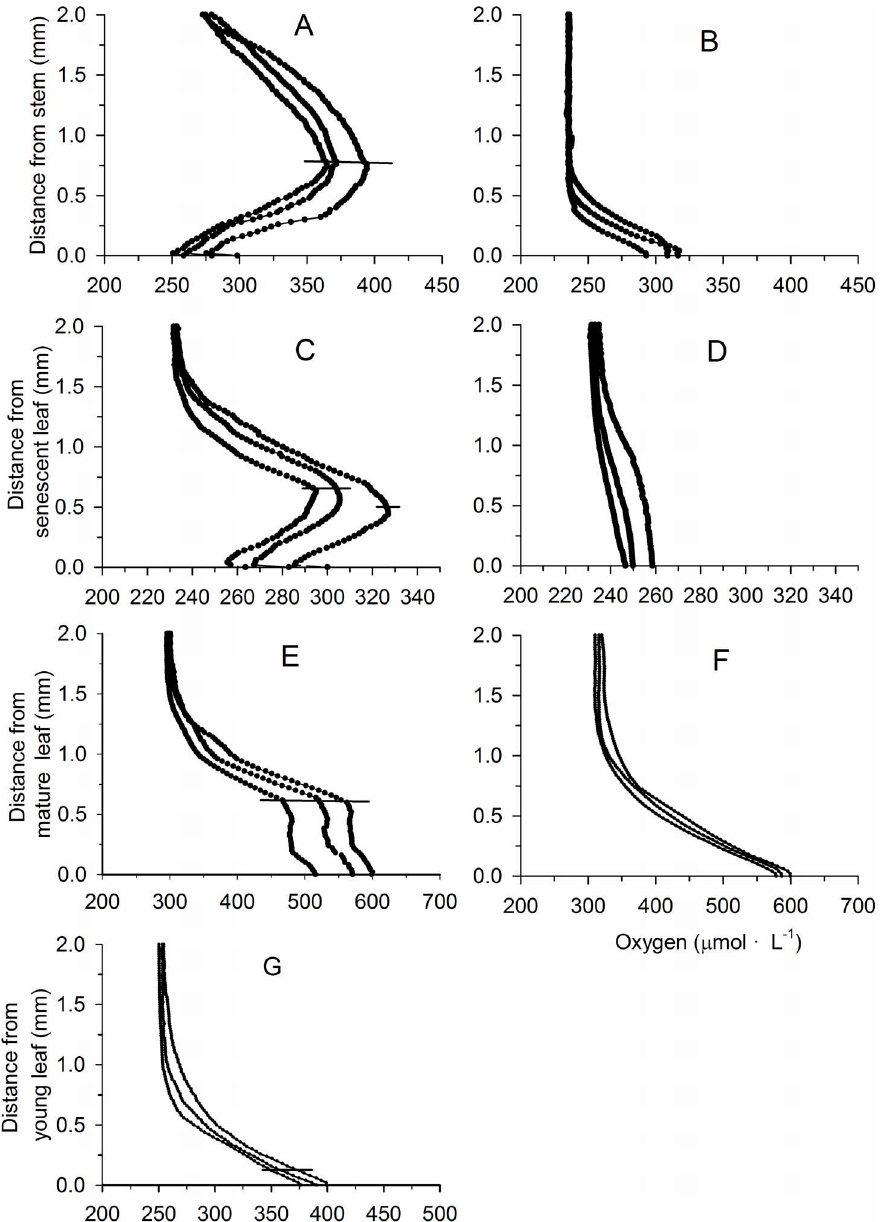
Figure 1. Microprofiles of oxygen around Potamogetonmalaianus stems and leaves with and without periphyton. A, C, and E indicate thick periphyton; B, D, and F indicate periphyton removed; G indicates young leaves with little periphyton. Microprofiles were measured at three different points under quantum flux density of 300 m mol photons ? m –2 ? s –1 on P. malaianus stems and leaves. The outer surfaces of the periphyton layer are indicated by horizontal bars. The leaf surfaces are indicated by 0. Microprofiles of oxygen around young leaves were not markedly different between the presence of little periphyton and periphyton removed. doi:10.1371/journal.pone.0101825.g001 points; Fig. 1A, D, G). O 2 concentrations at the surface of stems, senescent leaves, and mature leaves were 262.2 6 19.9 m mol ? L –1 ,